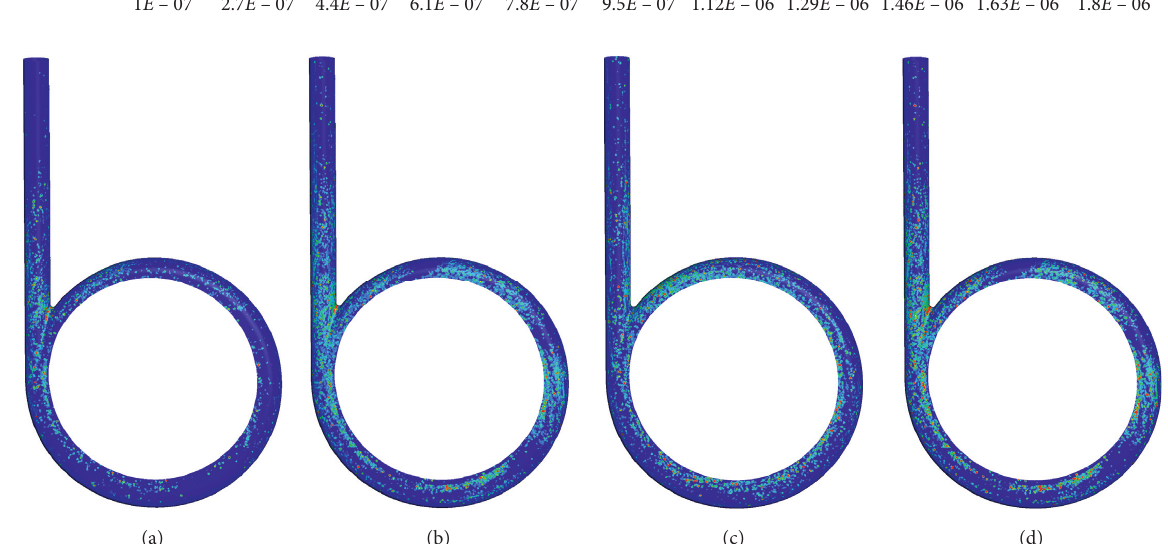
Figure 6: Volute wear clouds at different flow rates. (a) Q � 9.6m 3 · h − 1 , (b) Q � 12.8m 3 · h − 1 , (c) Q � 16m 3 · h − 1 , and (d) Q � 19.2m 3 · h − 1